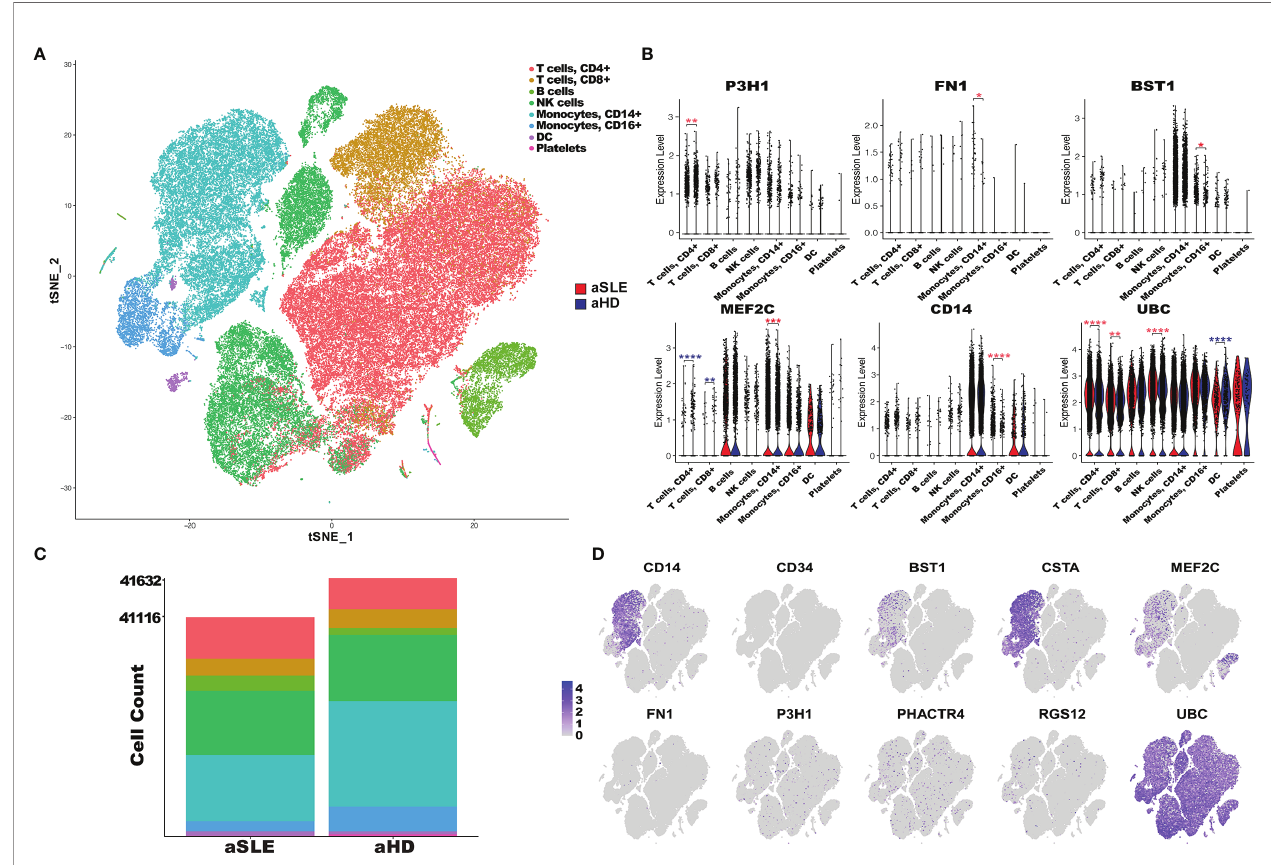
FIGURE 6 | PBMC scRNA expression of autoantigen candidates in SLE patients and healthy controls. (A) tSNE plot of 82,748 cells across 23,257 gens from the PBMC sample of 8 adult SLE patients (aSLE) and 5 adult healthy controls (aHD). Clusters were derived from PCA reduction with the fi rst 18 dimensions, and the clusters ’ cell type was identi fi ed with SingleR reference databases and canonical markers. (B) The bar plot represents the cell abundance of 8 clusters across aSLE (41,116 cells) and aHD (41,632 cells) groups. (C) Violin plots of PBMC scRNA expression in 8 cell type clusters in aSLE (red) and aHD (cyan). The autoantigens ’ differential expression levels in each cluster were determined using the Wilcoxon test. The asterisks designate the level of signi fi cance: *p < 0.05, **p < 0.01, ***p < 0.001, ****p < 0. 0001, and increased or decreased expression in aSLE was colored in red and cyan, respectively. (D) Feature plots of 10 autoantigens; each dot represents one cell, and the color intensity indicates the gene expression level of autoantigen in the cells, from gray to